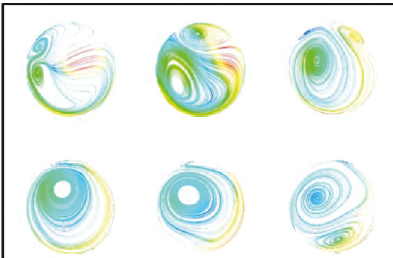
Figure 11: Secondary flow of sections (4)–(9). (The six figures in each part represent sections (4), (5), and (6) in the first row and (7), (8), and (9) in the second row from left to